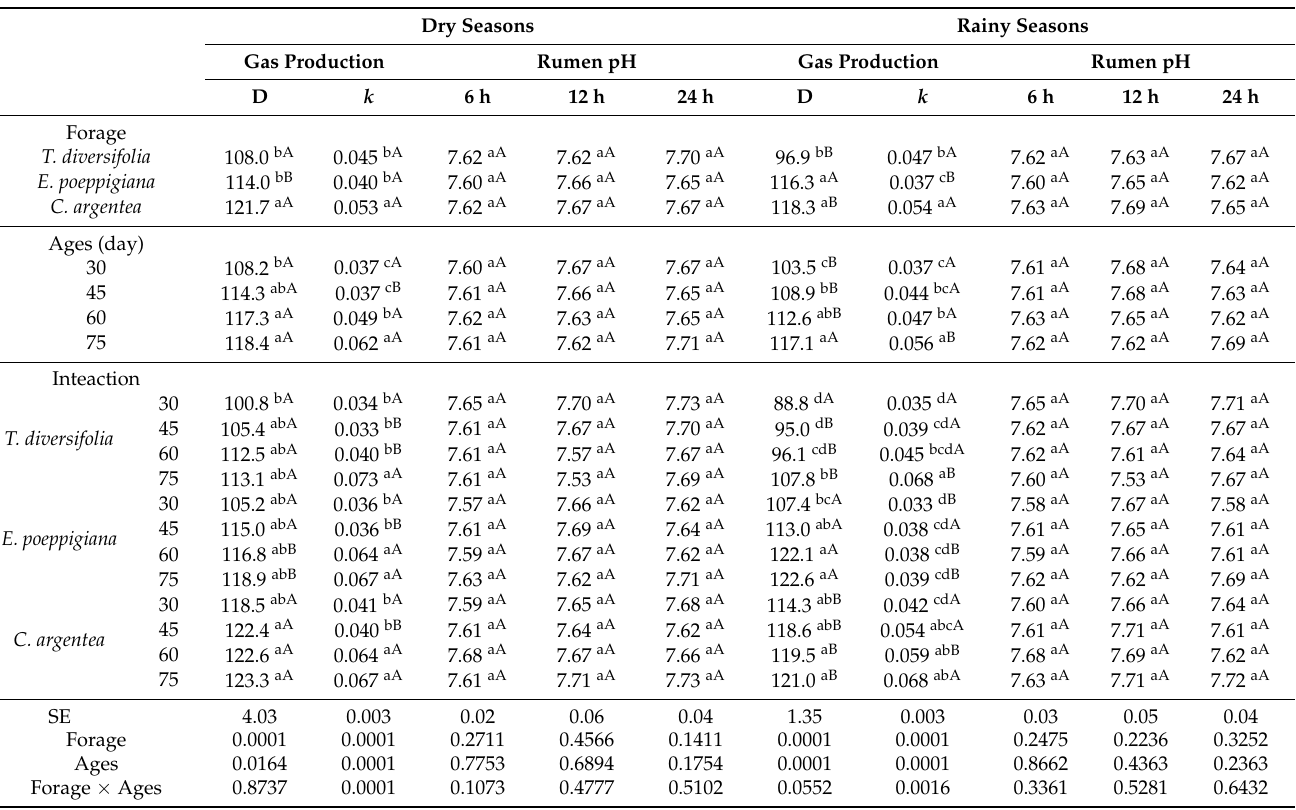
Table 1. In vitro gas production parameters (mL gas/0.400 g incubated DM) and rumen pH of shrub and tree species at different cutting ages, in the dry and rainy